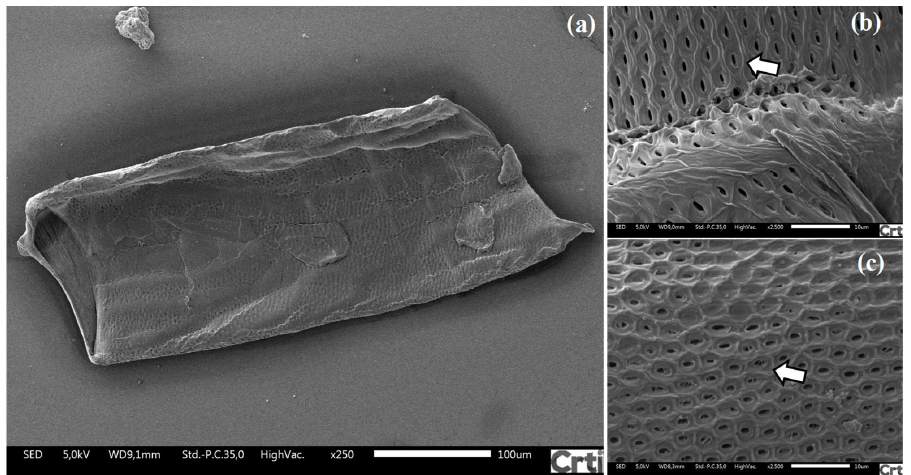
Figure 3. Field emission scanning electron microscopy of the vessel of Khaya grandifoliola . ( a ) Full-length xylem vessel; ( b , c ) details of secondary wall thickening.